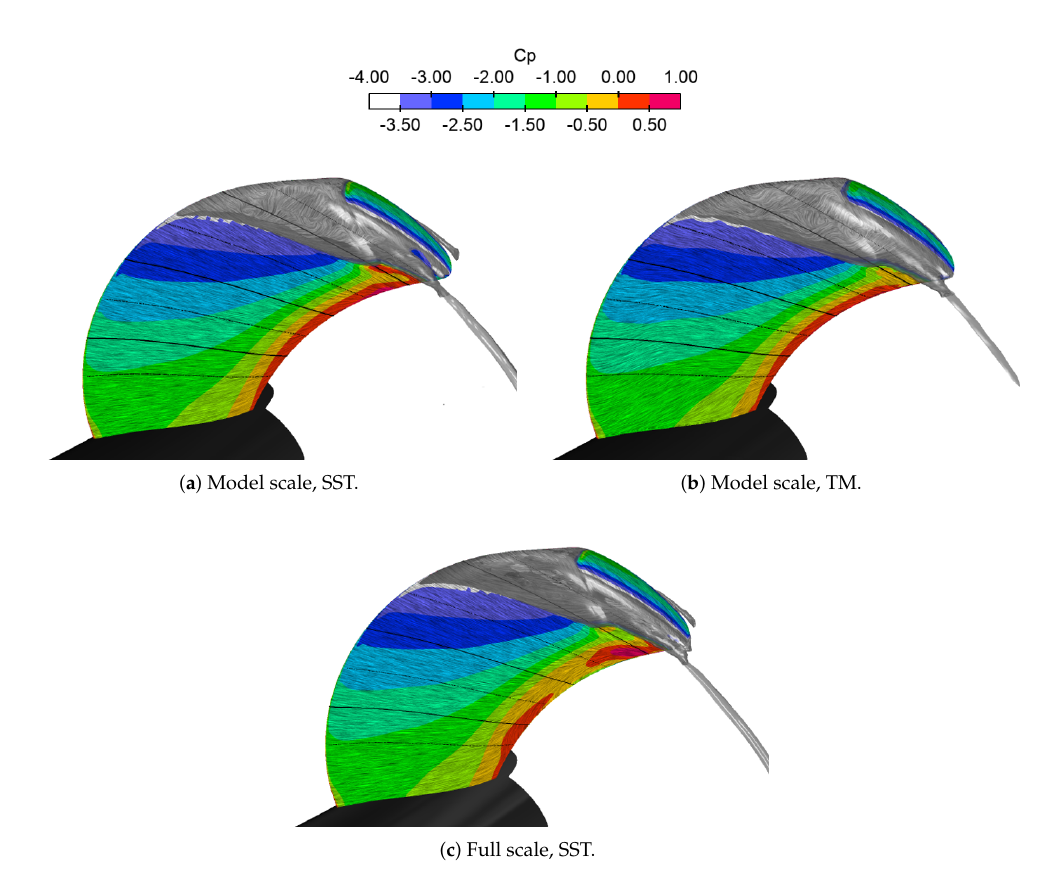
Figure 35. Comparison of blade pressure coefficient for